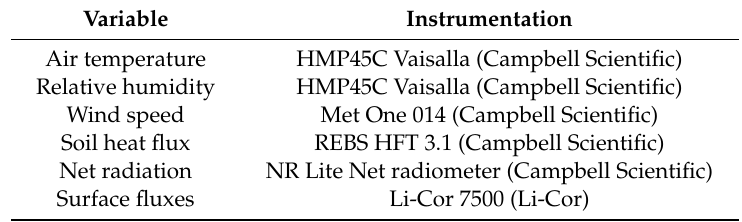
Table 1. Description of micrometeorological and eddy covariance